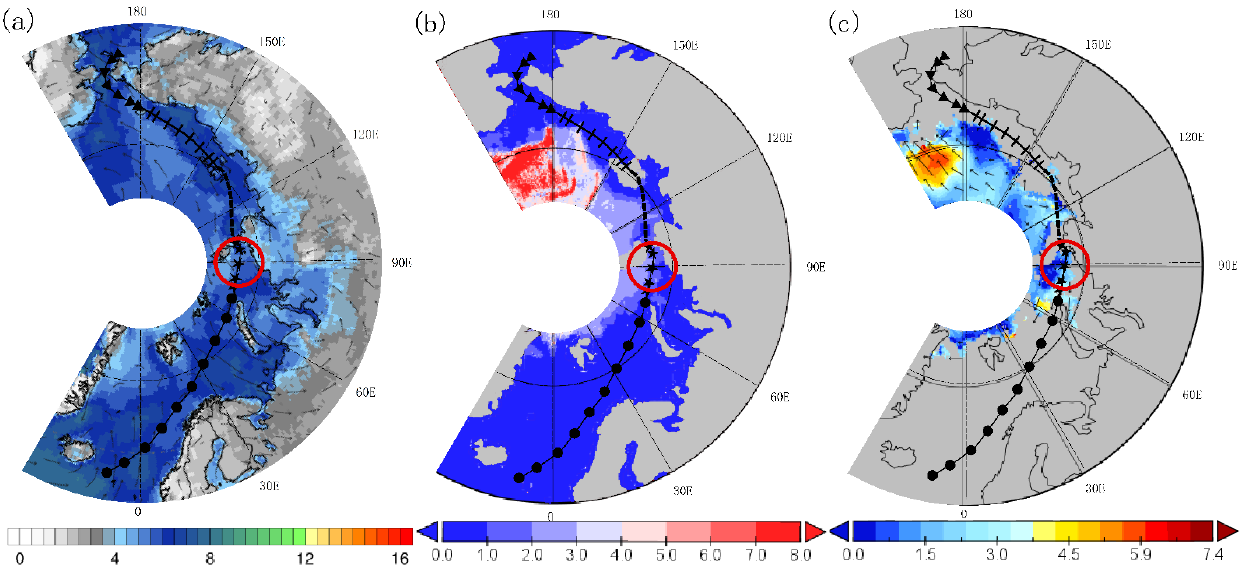
Figure 12. The average wind field ( a ), sea ice age ( b ) and sea ice movement ( c ) of the NEP in the Arctic in August 2002.